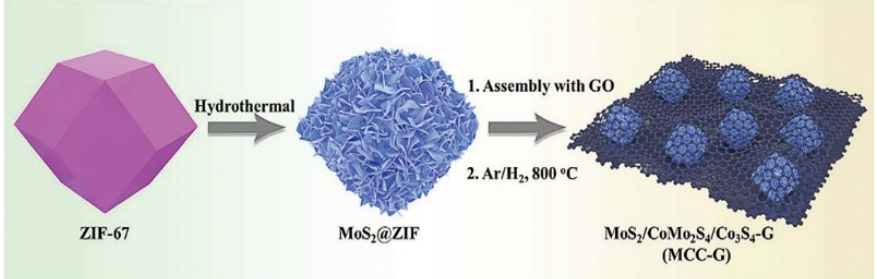
Figure 8. Schematic illustration for the fabrication of MoS 2 /CoMo 2 S 4 /Co 3 S 4 supported by graphene. Reproduced with permission from Pengcheng Wang, Constructing MoS 2 /CoMo 2 S 4 /Co 3 S 4 nanostruc- tures supported by graphene layers as the anode for lithium-ion batteries; published by Royal Society of Chemistry, 2020 [71].